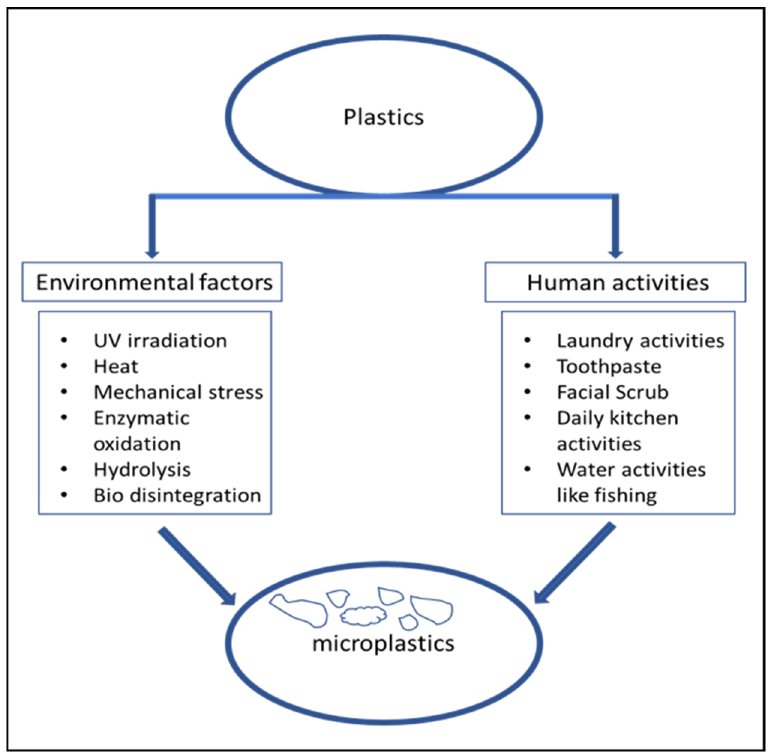
Figure 1. Factors responsible for the formation of MPs.